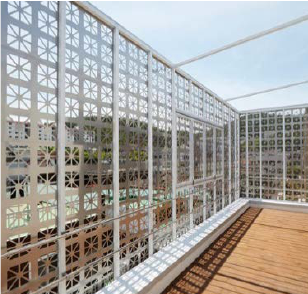
Fig 9(a) Screening Façade of Lotus Haus Fig 9(b) Screening covering residential floors